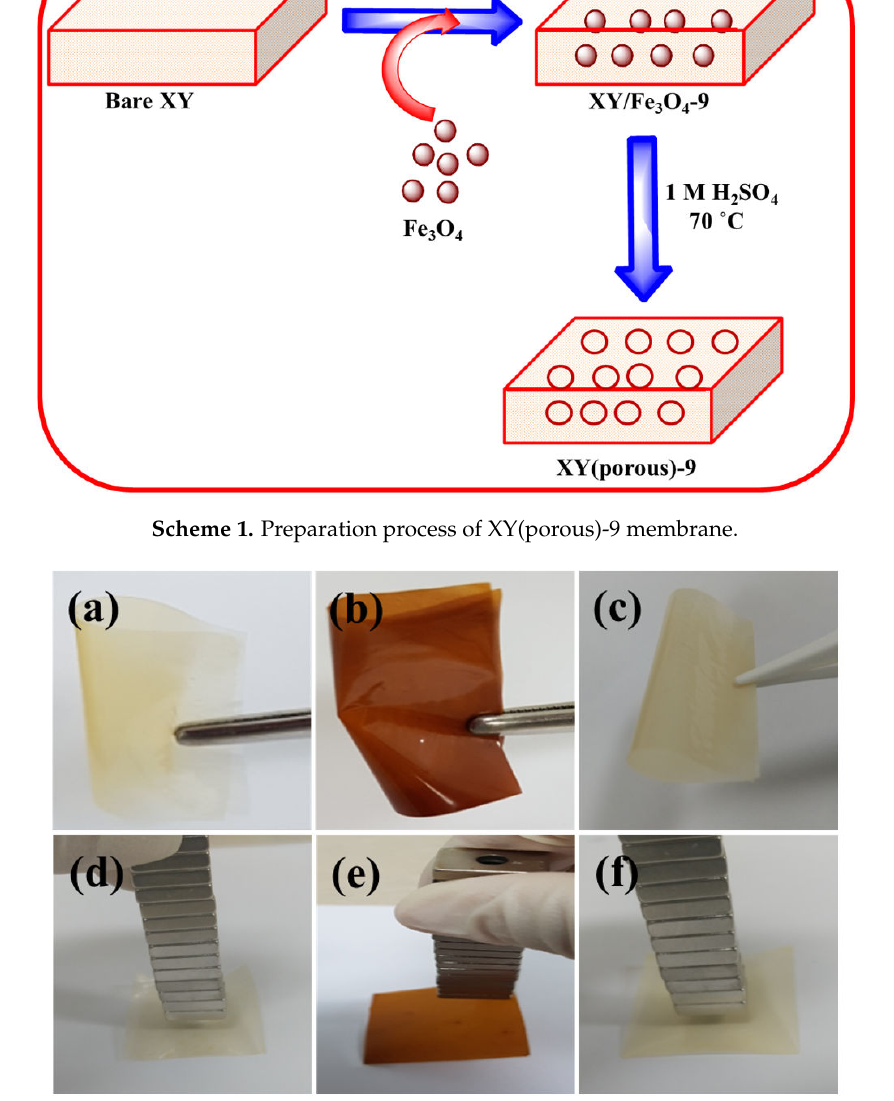
Figure 1. Digital photographic images ( a , d ) XY, ( b , e ) XY/Fe 3 O 4 -9, and ( c , f ) XY(porous)-9